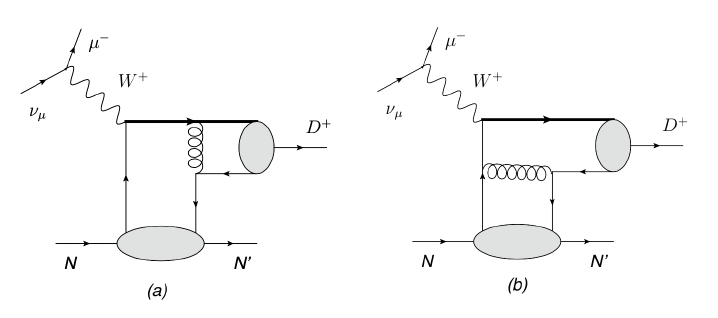
Figure 1. Feynman diagrams for the factorized amplitude for the ν μ N → μ − D + N (cid:3) or the ν μ N → μ − D 0 N (cid:3) process involving the quark GPDs; the thick line represents the heavy quark. In the Feynman gauge, diagram (a) involves convolution with both the transversity GPDs and the chiral even ones, whereas diagram (b) involves only chiral even